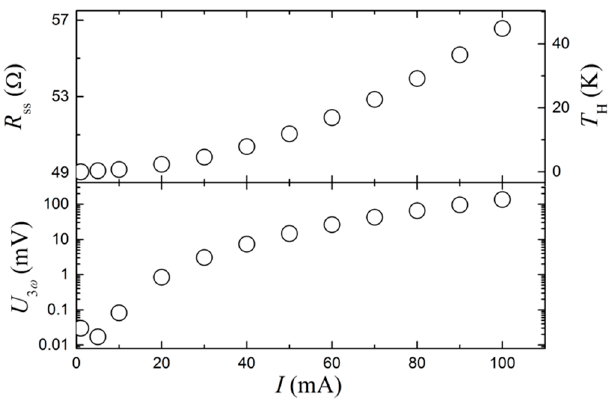
Figure 4. The upper panel shows the electrical resistance ( R ) and self-heating temperature ( T H ) as a function of the current. The lower panel shows the amplitude of the 3 ω signal ( U 3 ω ) as a function of the current.